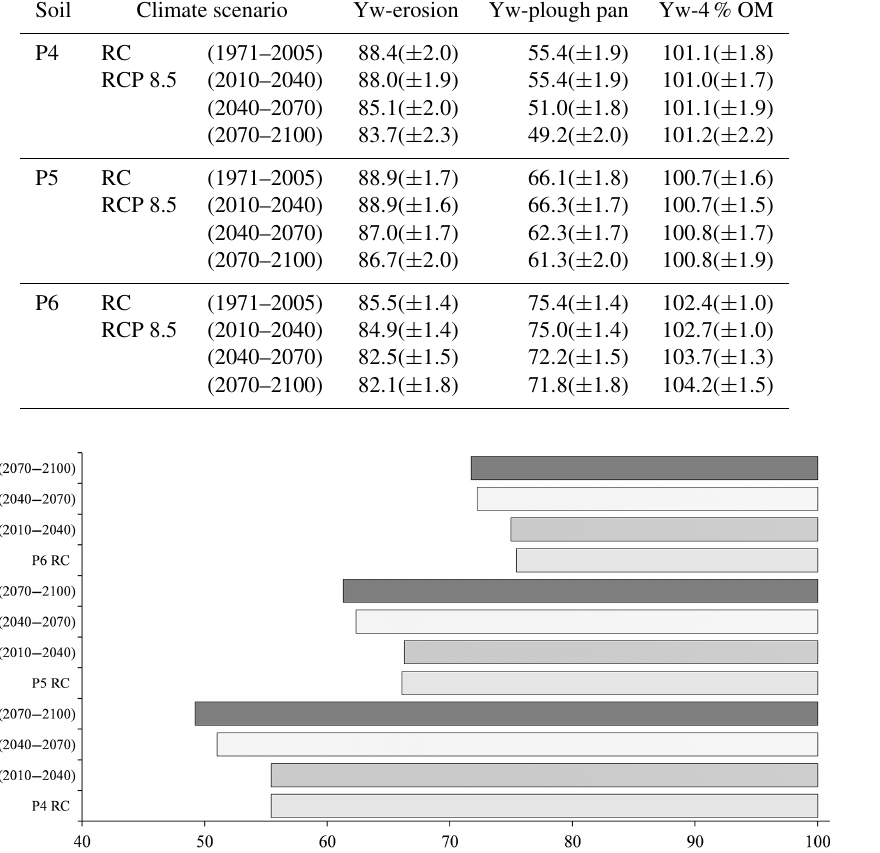
Table 2. Soil health (SH) indexes, i.e. (Yw-phenoform/Yw-ref) × 100, defining actual conditions for three selected soils being studied for four climate periods, as indicated. Values are reported for the non-degraded soil and for hypothetical phenoforms representing the erosion of 20cm of topsoil without a change in soil classification (Yw-erosion) and the occurrence of a plough pan at 30cm depth (Yw-plough pan). Indexes are also included for hypothetically increased percentages of organic matter (OM) to levels of 4% (Yw-4% OM). Soil Climate scenario Yw-erosion Yw-plough pan